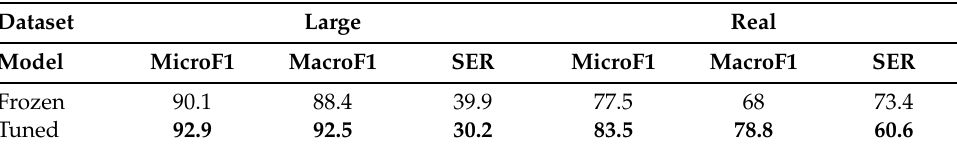
Table 6. F1 scores and sanad error rate (SER) of the models trained on the large dataset. The Large section shows performance on the validation set of artificial sanad s. The Real section shows perfor- mance on the test set of real sanad s. FrozenAraBERT uses pretrained AraBERT with a classification layer. TunedAraBERT uses pretrained AraBERT and initialize the classification layer with the trained parameters from FrozenAraBERT and fine-tune